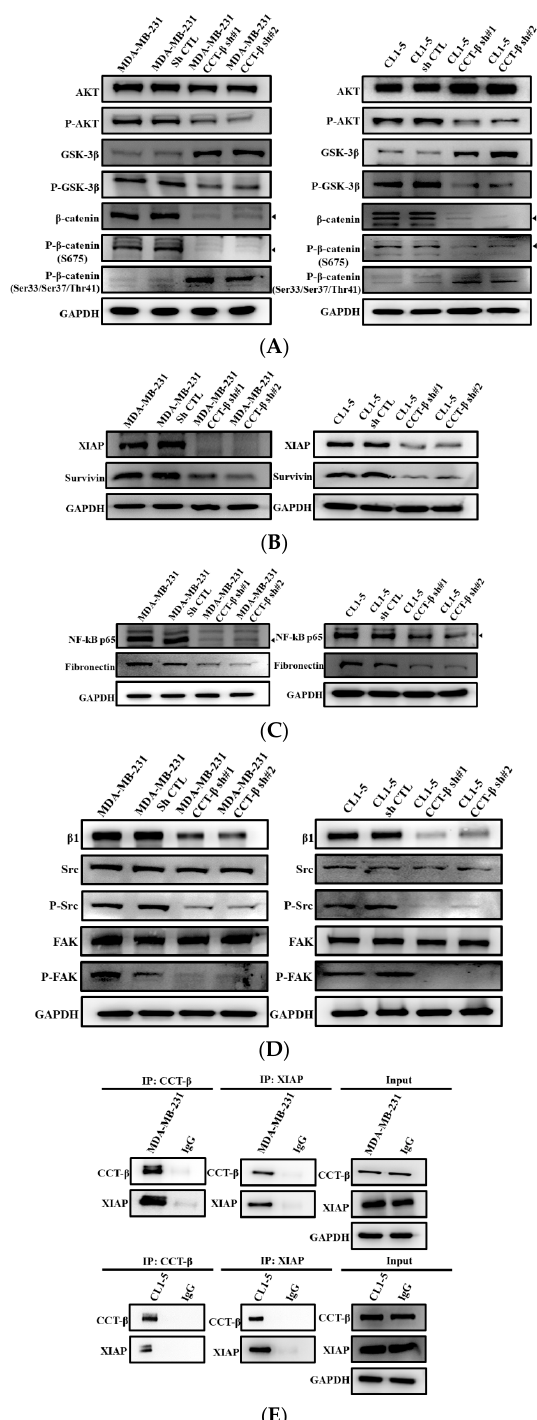
Figure 8. CCT- β knockdown affected the expression levels of proteins in the AKT-GSK3 β - β -catenin and XIAP-Survivin signaling pathways. ( A – D ) CCT- β knockdown suppressed the expression of proteins in the β -catenin and XIPA-Survivin pathways. The cell lysates were collected for western blotting. GAPDH was used as a loading control. ( E ) Coimmunoprecipitation analysis revealed the physical association between CCT- β and XIAP in the MDA-MB-231 and CL1-5 cells. IgG means control, non-immune